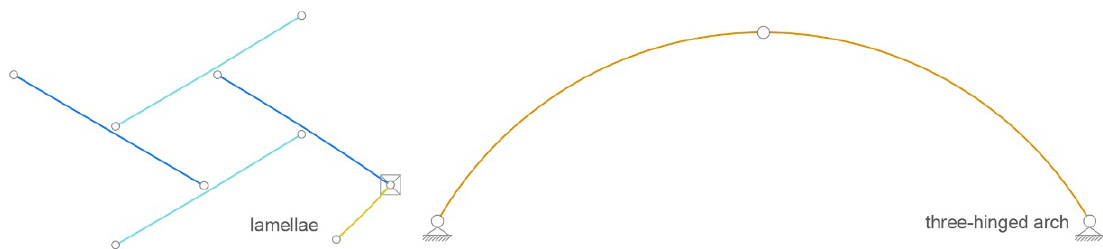
Figure 12. The lamellae and three-hinged arch, as in the finite element model.